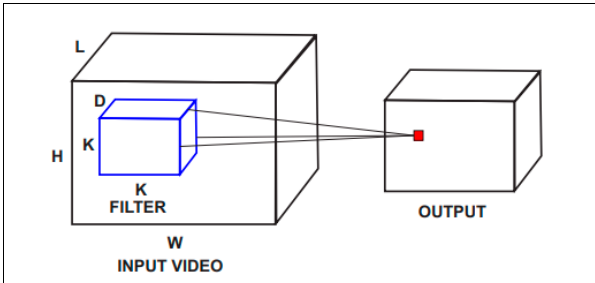
Figure 2. 3D-convolution operation.